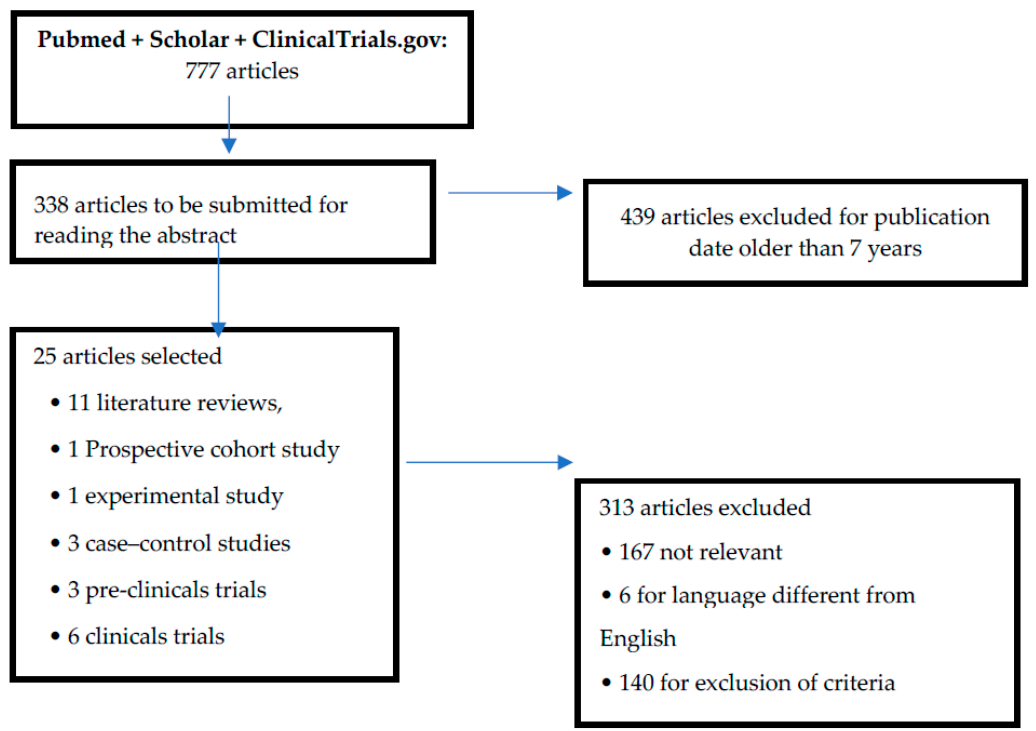
Figure 1. Flow diagram of the literature selection and review process.